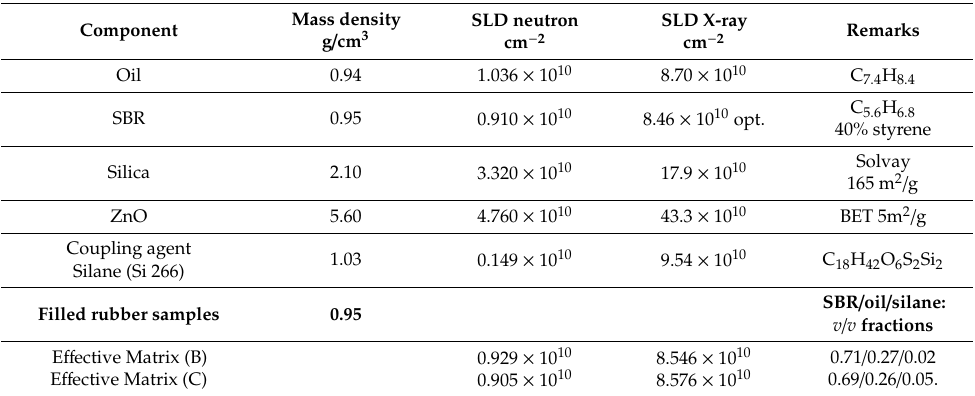
Table 3. Mass densities and scattering length densities for the most significant components of the mixture (amount > 2.5 phr). Only for SBR, the experimental value for the SLD in the case of X-rays was optimized against experimental data (see text).